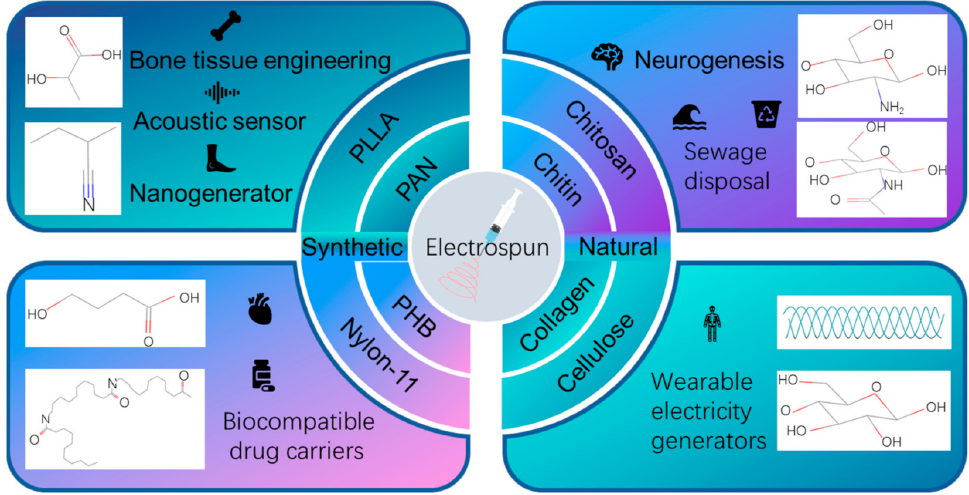
Figure 10. Structures and applications of other piezoelectric NFs prepared by